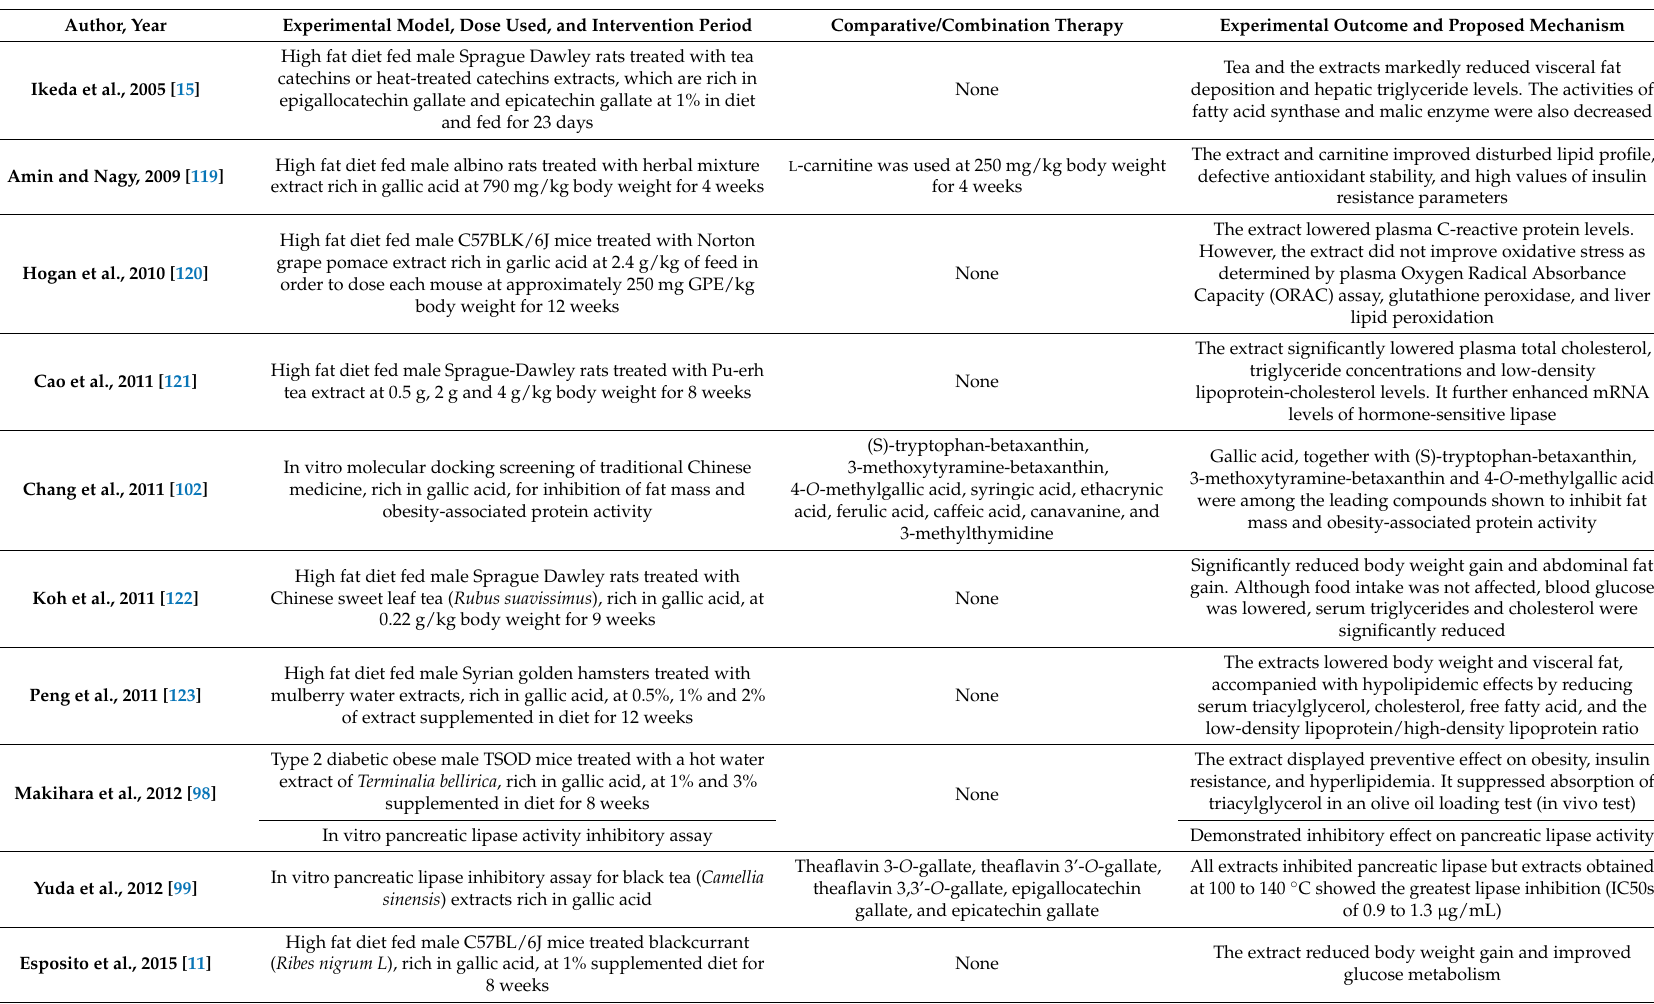
Table 3. Overview of studies reporting on the ameliorative effect of tea and fruits-rich in gallic acid against obesity-associated